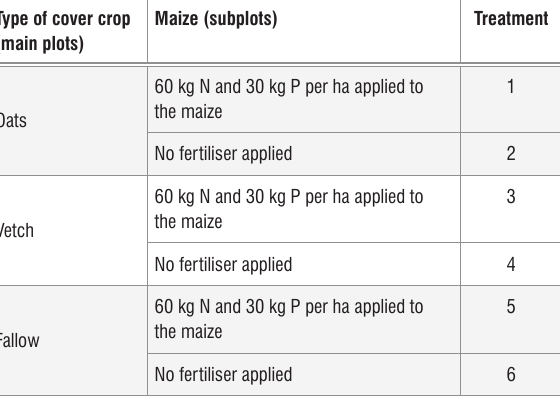
Summary of analysis of variance of the effects of winter cover crop type and fertiliser on phosphorus pools after 4 years of maize–winter cover crop rotation